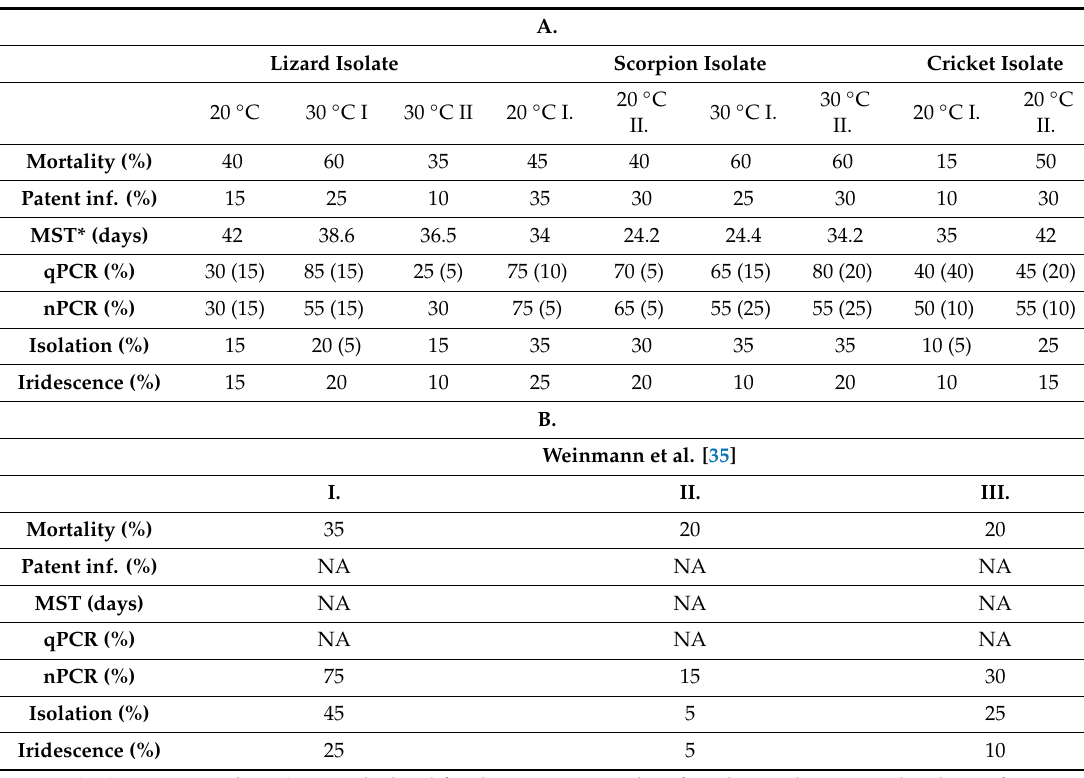
Table 3. Comparison of the (A) here described controlled-temperature cricket bioassay results with (B) those of three replicates (I–III) of an earlier study in our laboratory [35], which was performed with non-controlled temperatures.